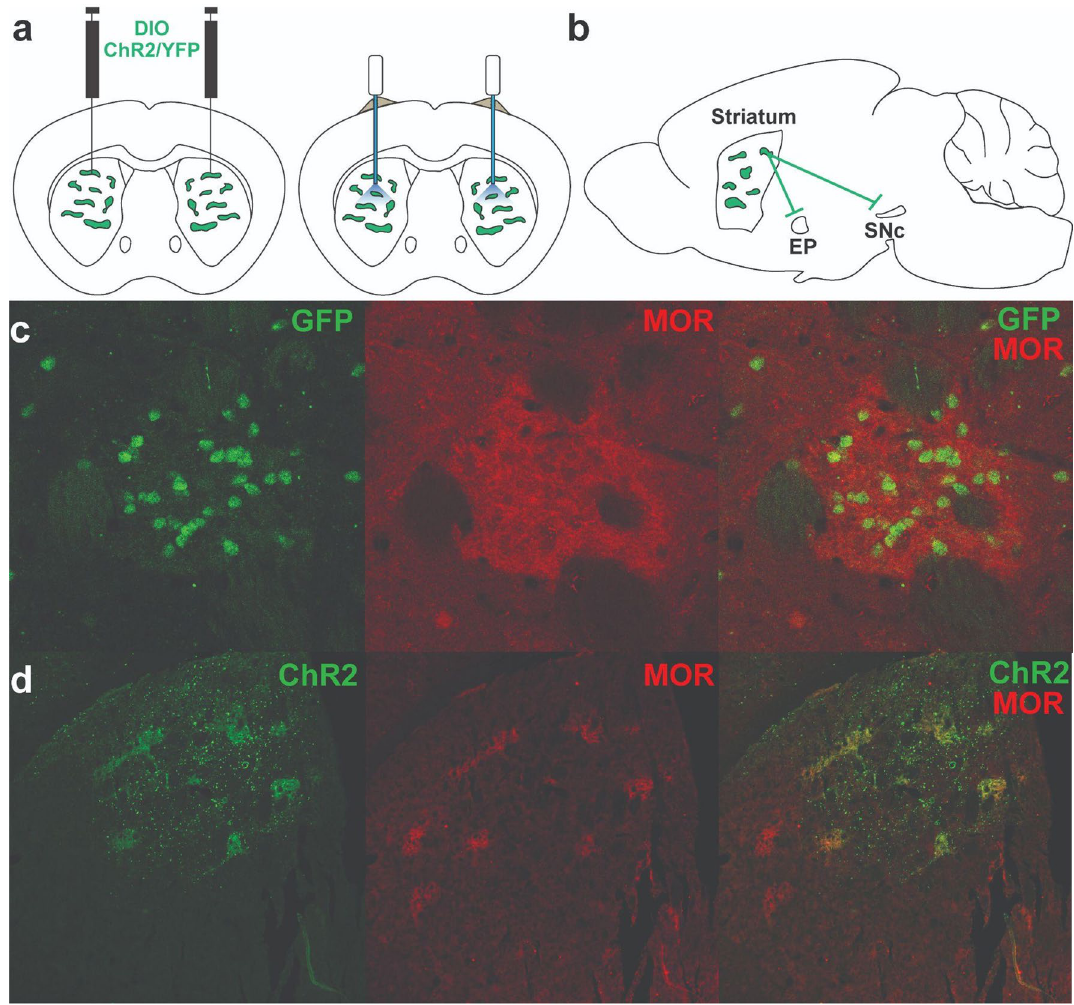
Figure 1. Experimental design and characterization of Sepw1-Cre mice. ( a ) Experimental design. Bilateral AAV driving expression of channelrhodopsin-2 (ChR2) or YFP was injected into the dorsal striatum (left). Fiber optics were affixed just dorsal to injection site (right). ( b ) Patches in striatum, or patch projections to entopeduncular nucleus (EP) or substantia nigra pars compacta (SNc) were targeted with fiber optic implants. ( c ) Coronal section showing Cre dependent expression of GFP and µ-opioid receptor expression demonstrating enriched Cre expression in a striatal patch. ( d ) Coronal section showing AAV5-driven expression of ChR2-eYFP overlaid with µ-opioid receptor expression. ( a + b ) drawn in Illustrator CC 2019 that stimulation of patches elevates press and entry rates during VI60 when stimulation is paired to rewarded head entries, and that modulation of patches impairs day-to-day press rate consistency. Patch stimulation may elevate response rates by acutely increasing the speed of transitions between presses and head entries during VI60 trials, or by modifying the sequence of behavioral events during VI60. To distin- guish between these possibilities, we compared the time between rewarded presses and reward retrieval, as well as the time between reward retrieval (when optogenetic stimulation occurs) to the next press. Patch stimulation did not alter either of these metrics relative to YFP controls by the final day of VI60 training (unpaired t-test, p ≥ 0.926; Fig. 2j and k). We then assessed how patch stimulation changed the structure of responding during VI60 by determining the number of presses that occurred between each head entry and comparing these values between days 1 and 8 within stimulation groups. We found that patch stimulation drove a significant increase in the number of presses per head entry across the eight days of VI60 training (t 44 = 3.092, p = 0.0034; Fig. 2l). This change occurred concurrently with a decrease in the number of single presses between head entries across VI60 (t 44 = 3.222, p = 0.0024; Fig. 2m), suggesting that on average, YFP and ChR2 mice differently modify the number of lever presses during press bouts between head entries. Overall, these data suggest that activating striatal patches across training biases the structure of responding towards increased presses per bout as opposed to invigorating the rate of transitions between behavioral events.